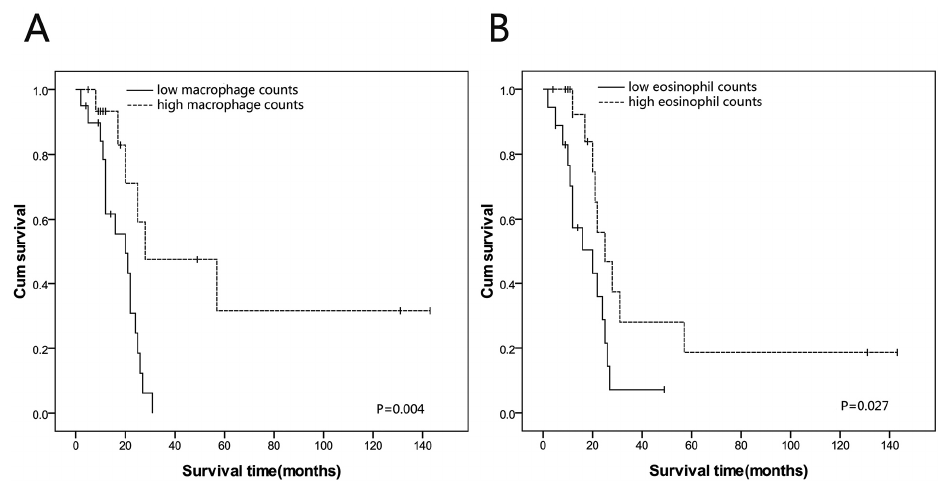
Figure 2. Kaplan-Meier survival curves of SmCEC patients ( A ) High macrophage counts in SmCEC correlated with better overall survival ( p = 0.004); ( B ) High eosinophil counts in SmCEC correlated with better overall survival ( p = 0.027).